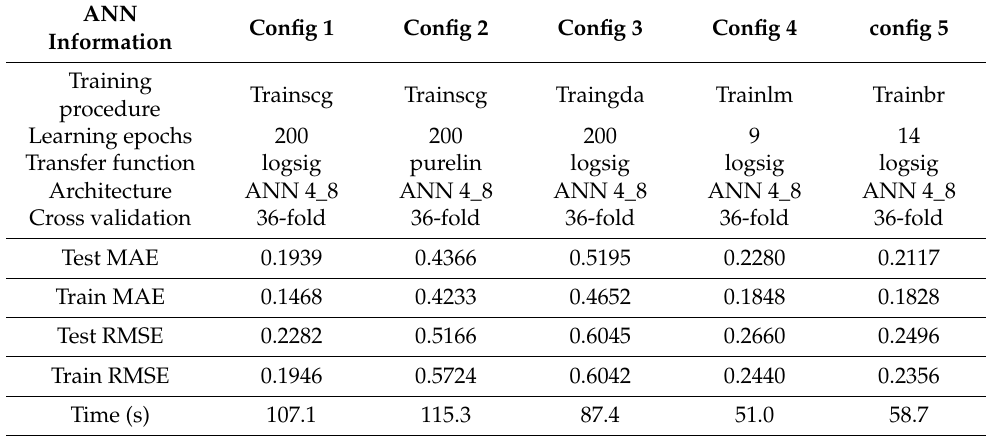
Table 10. Tested feed-forward ANN configurations, with the AR parameter